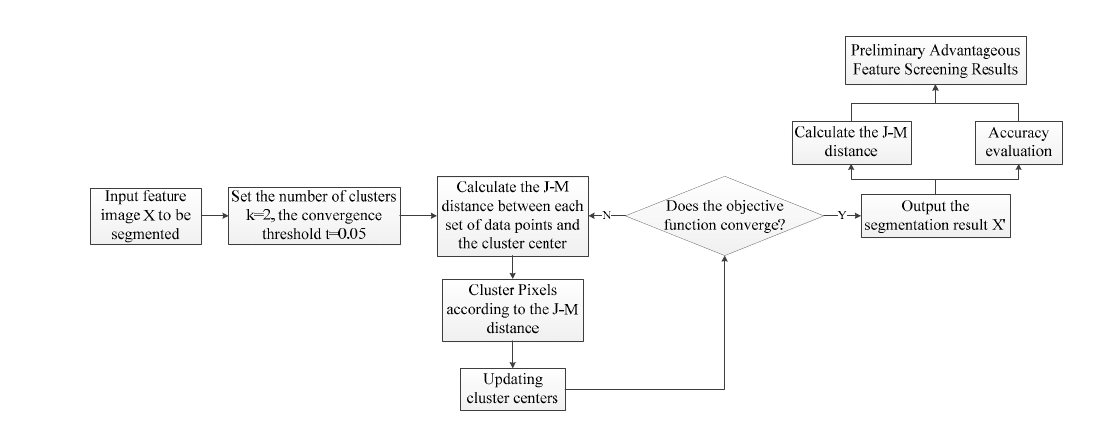
Figure 1. Workflow of weakly supervised model for oil emulsion detection and identification.